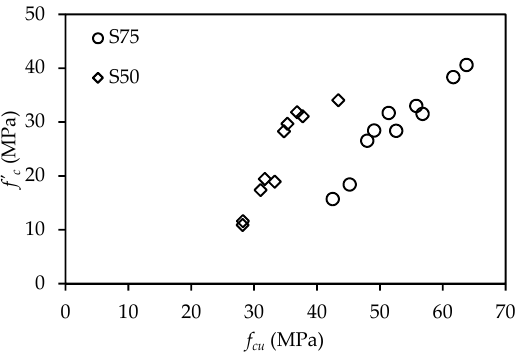
( c ) Figure 10. Typical compression stress-strain curves of RCA alkali-activated slag-fly ash (3:1) concrete mixtures with RCA replacement of ( a ) 30%, ( b ) 70%, and ( c ) 100%.